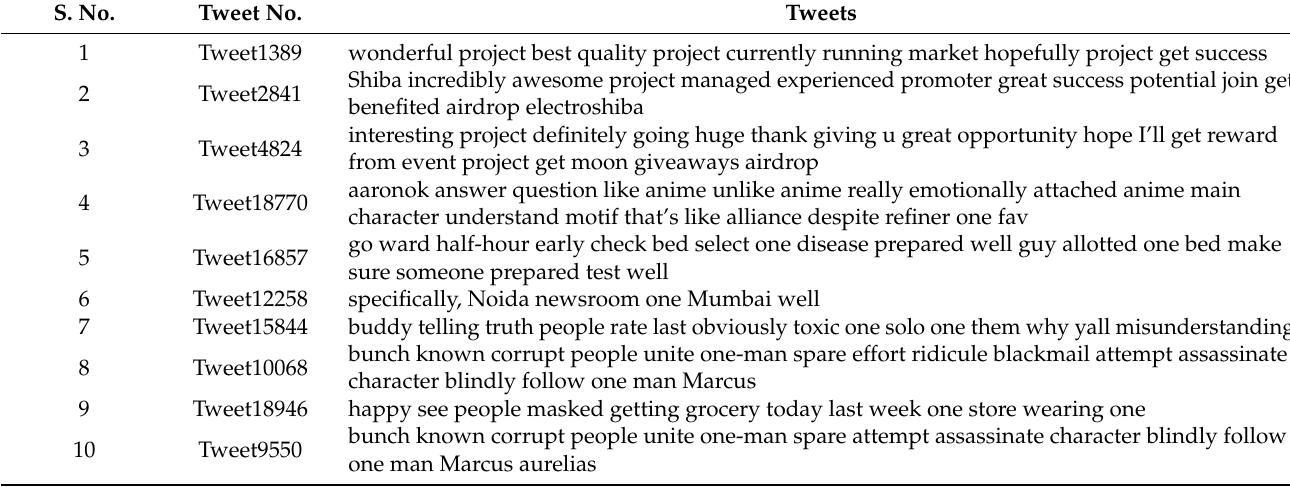
Table 5. Sample of most dominant